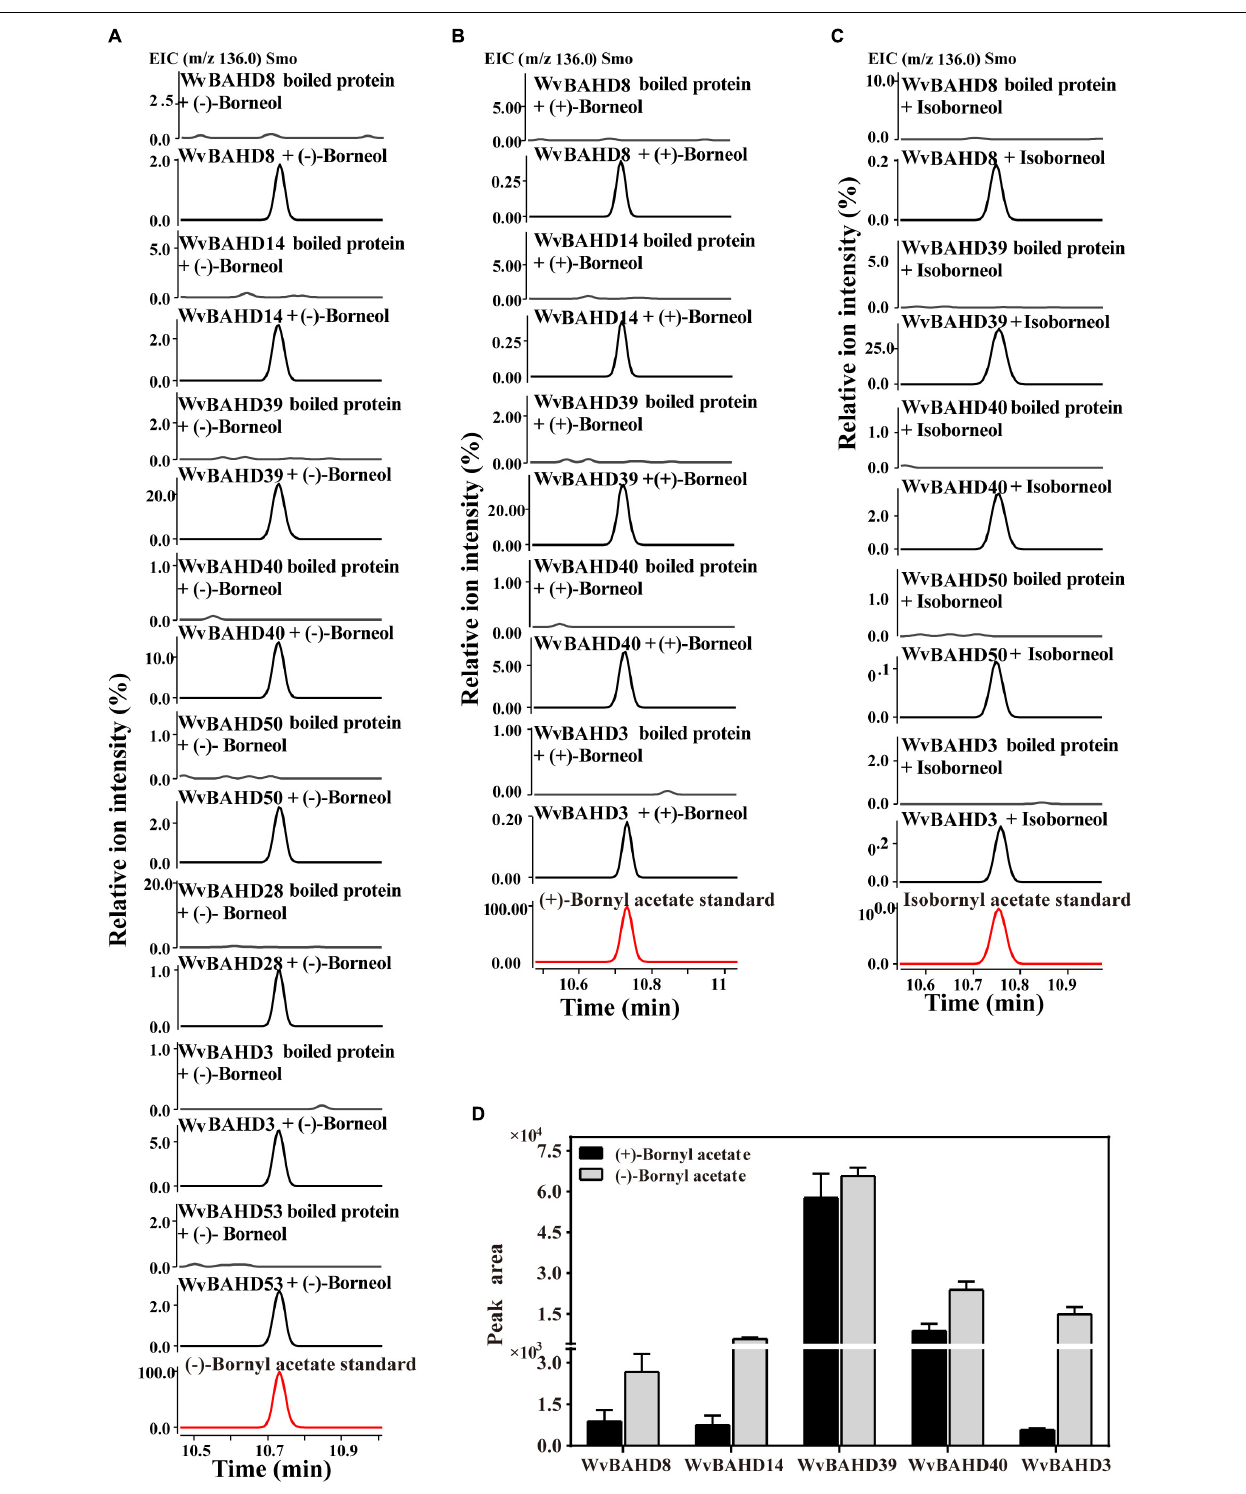
FIGURE 5 | Functional characterization of WvBAHDs. (A–C) The gas chromatography (GC)–mass spectrometry (MS) chromatogram of the in vitro reaction products yielded by each WvBAHD using ( − )-borneol, (+)-borneol, and isoborneol as the substrate, respectively. (D) The GC-MS chromatograms peak area (EIC, m/z 136.0) of products yielded by each WvBAHD at the same substrate concentration (enzyme concentrations vary among WvBAHDs), using ( − )-borneol, (+)-borneol, and isoborneol as the substrate, respectively.